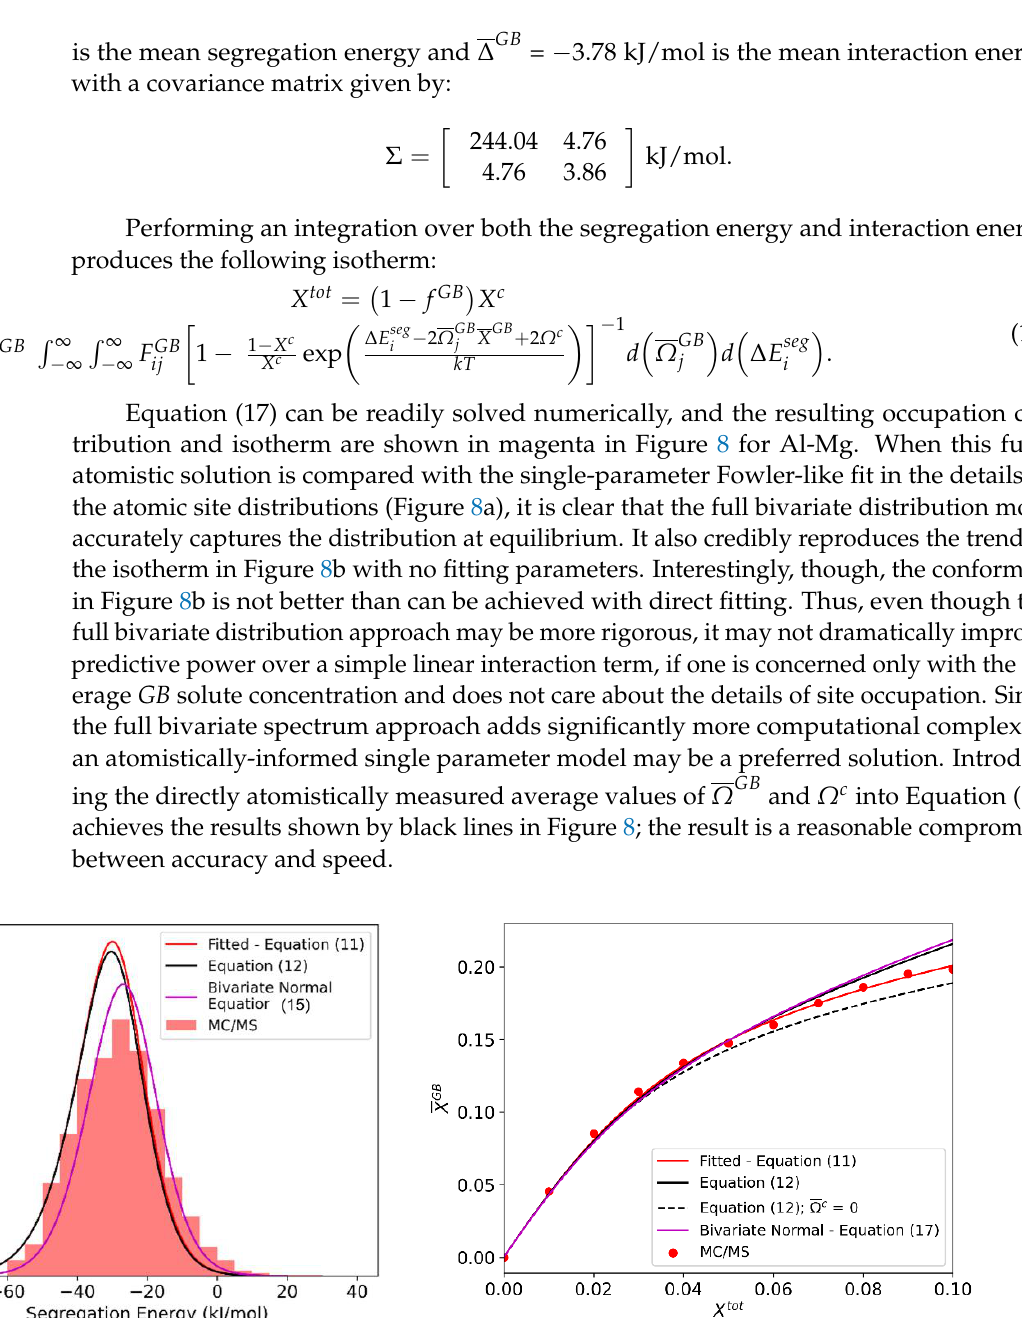
GB = − 27.10 kJ/mol